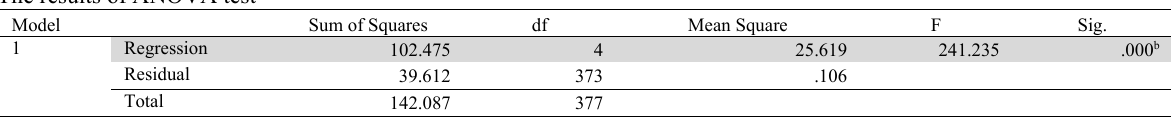
The results of ANOVA test Model